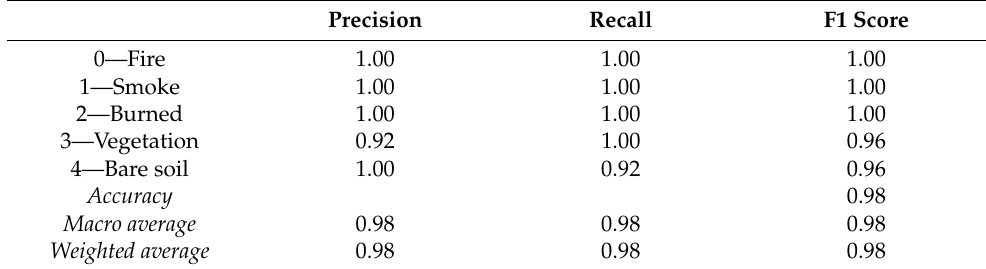
Table 7. Validation dataset